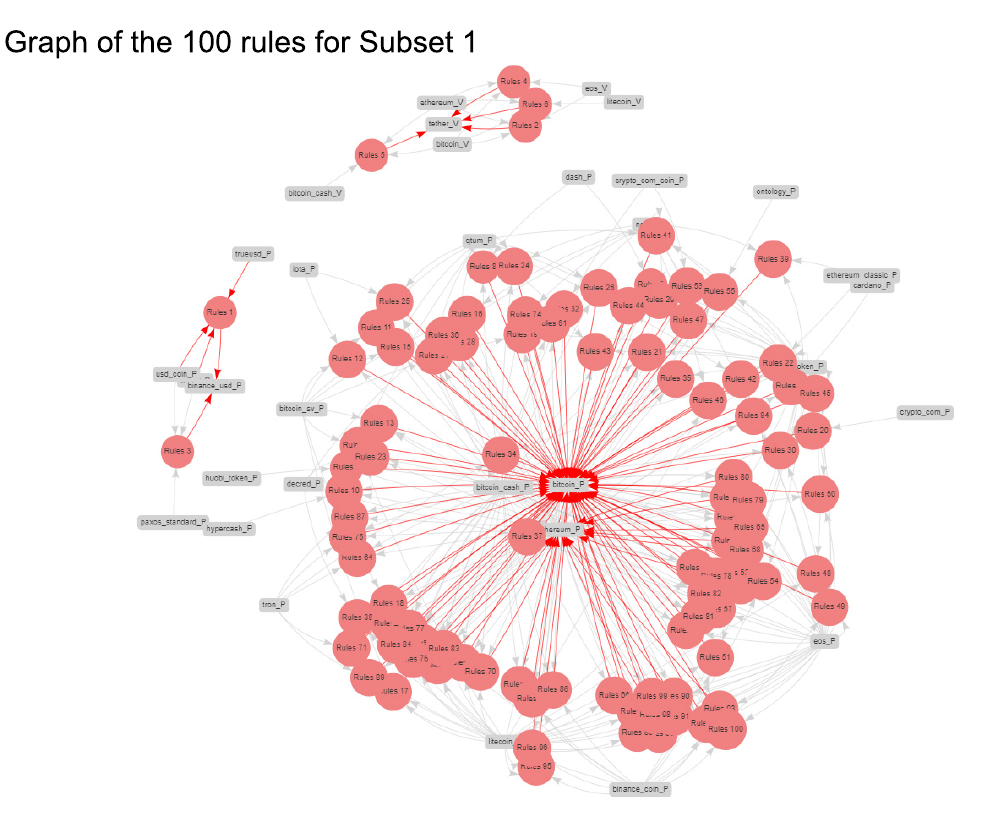
Figure 9. Directed graph of the 100 rules for Subset 1.